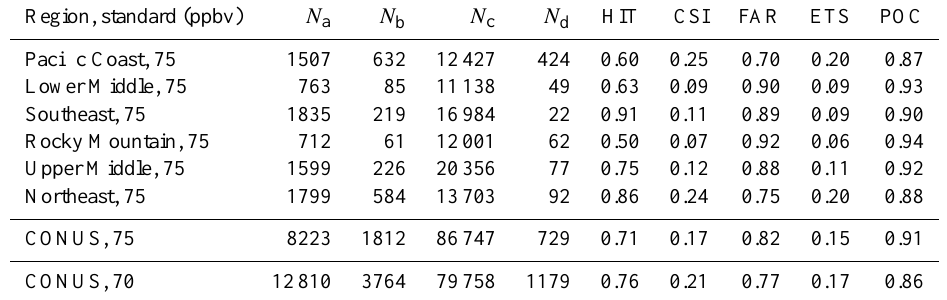
Table 6. Daily maximum eight-hour ozone categorical statistics for summer months (June–August) in 2010, See text for details. Region, standard (ppbv) N a N